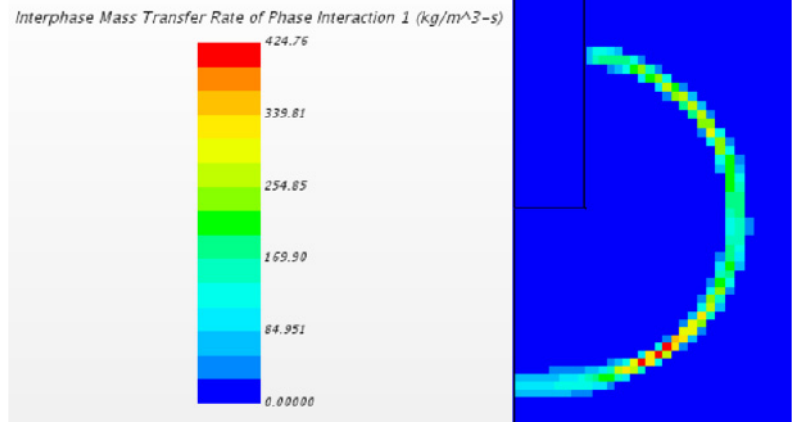
Figure 7. Condensation rate contour in case of steam injection [73].